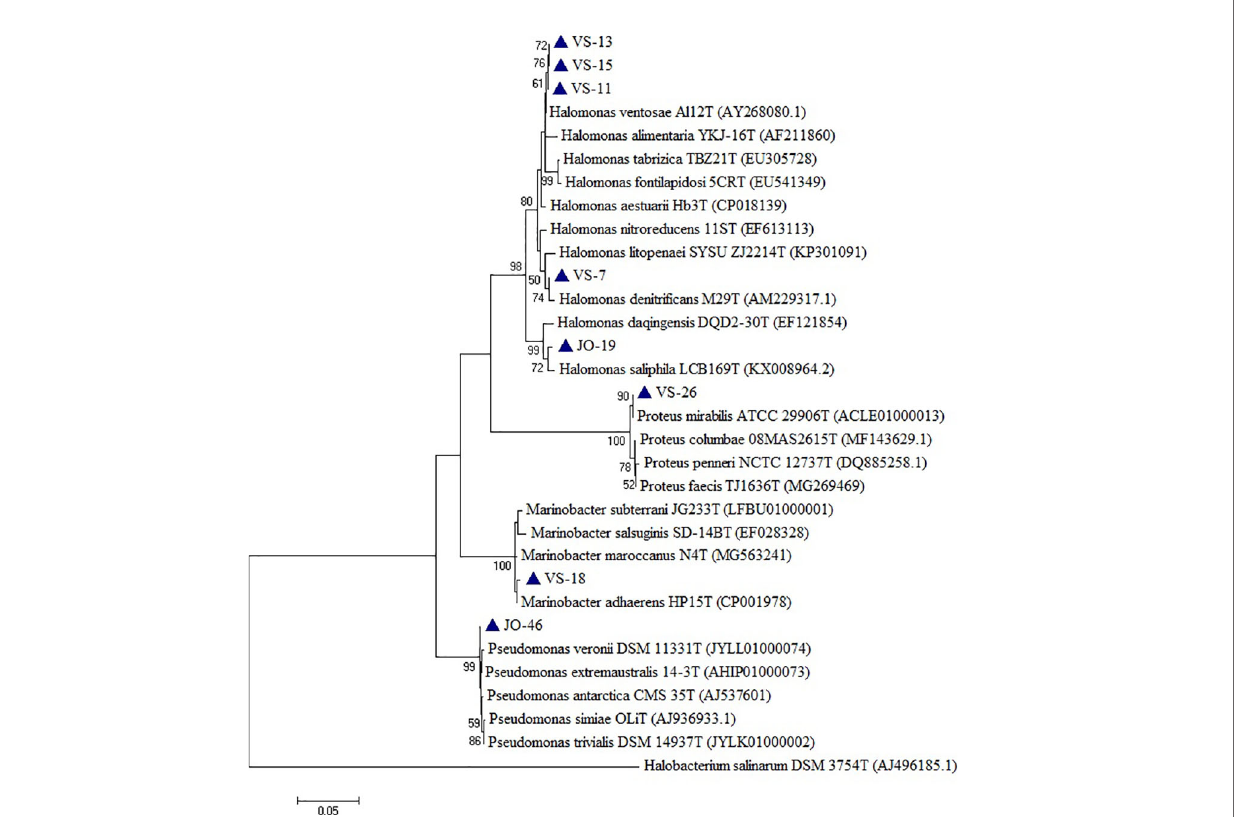
FIGURE 5 | Phylogenetic tree constructed using 16S rRNA gene sequences of LRK isolates belonging to Proteobacteria phylum and their closest phylogenetic relatives. The tree was reconstructed by the Maximum Likelihood method using MEGA 6 software. Halobacterium salinarum DSM 3754 T was used as an outgroup. The numbers on the tree indicate the percentages of bootstrap sampling derived from 1,000 replications. Bar, 5 nt substitution per 100 nt. Blue triangles indicates the strains isolated in this